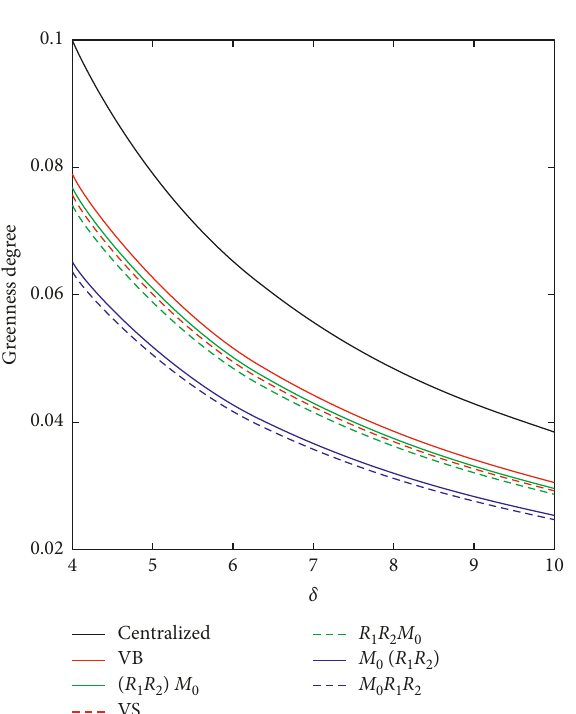
Figure 6: Effect of δ on the wholesale price in decentralized